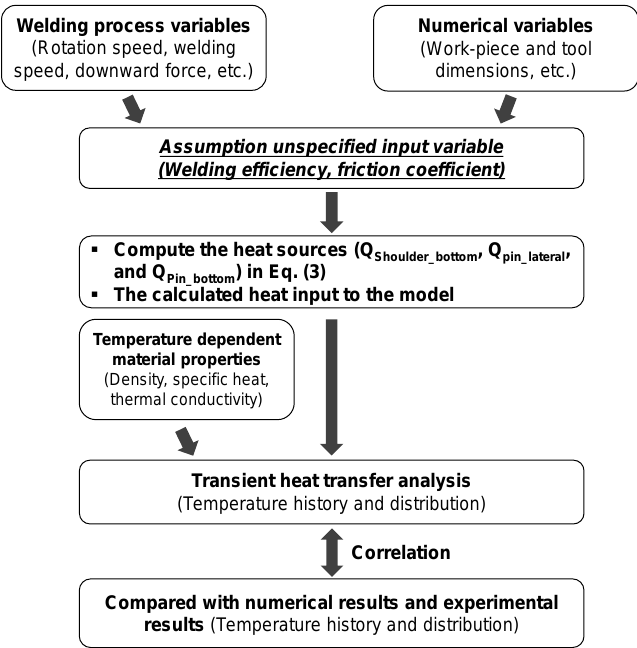
Figure 8. Calculation flow chart for heat transfer analysis.